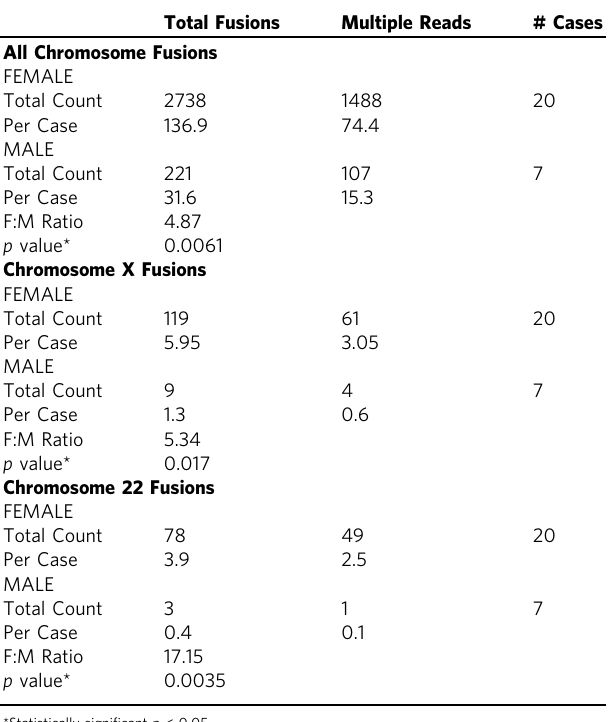
Table 2 Total chromosome fusions for all chromosomes, chromosome X and chromosome 22 for female and male